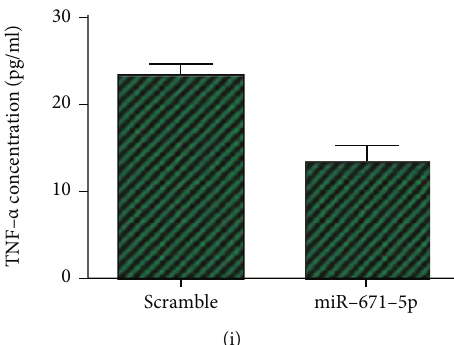
Figure 6: Ectopic expression of DLEU1 induced chondrocyte viability, degradation of ECM, and in fl ammation mediator secretion. (a) The expression of DLEU1 was measured by qRT-PCR analysis. (b) Ectopic expression of DLEU1 promoted cell viability in the chondrocytes using CCK-8 assay. (c) Elevated expression of DLEU1 suppressed collagen II expression in the chondrocytes. (d) The expression of aggrecan was detected by qRT-PCR assay. (e) Overexpression of DLEU1 induced ADAMTS-5 expression in the chondrocytes. (f) The expression of MMP-3 was measured by qRT-PCR assay. (g) DLEU1 overexpression promoted IL-6 expression in the chondrocytes using ELISA. (F) The expression of IL-8 was measured by ELISA. (i) The expression of TNF- α was measured by ELISA. ∗ p < 0 : 05 , ∗∗ p < 0 : 01 , and ∗∗∗ p < 0 : 001